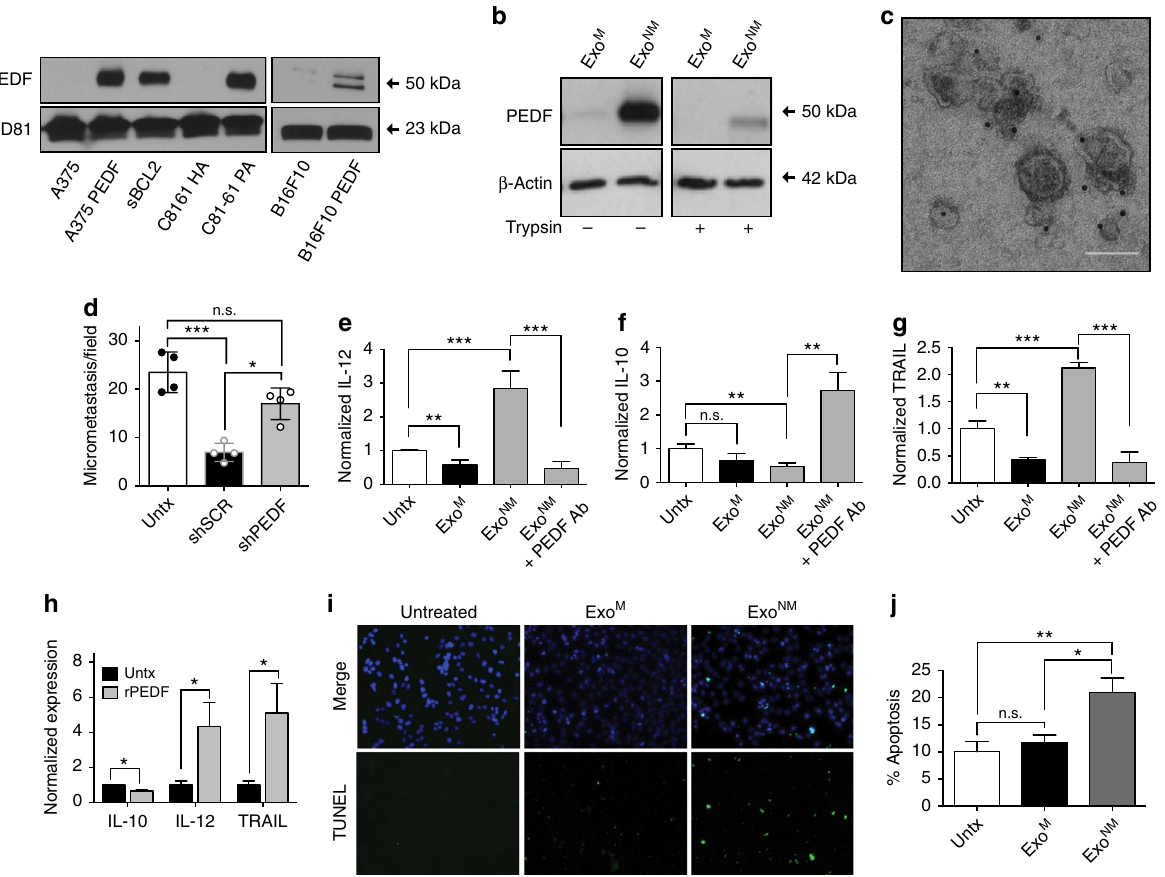
Fig. 5 The involvement of PEDF in exosome-driven melanoma cell clearance. a Western blot shows PEDF enrichment in exosomes from non-metastatic melanoma cell lines (A375 PEDF, SBcl2, C81-61PA, B16F10 PEDF) and the lack of PEDF in the metastatic exosomes (A375GFP, C8161 HA, B16F10 GFP, and C81-61 PA shPEDF). b Limited trypsin digestion indicates that PEDF is tethered to the outer lea fl et of exosomal membranes. Exosomal protein is loaded at 10 μ g per well. c Immunogold staining — TEM of Exo NM con fi rms PEDF localization to exosome surface. Scale bar, 100 nm. d Mice were pretreated with exosomes from non-metastatic C81-61 PA melanoma cells transfected with shPEDF lentiviral vector (shPEDF) or scrambled control shRNA miR (ShScr) ( n = 4, fi ve random images analyzed per animal for each condition). * P < 0.05 and *** P < 0.001 calculated by two-sided Student ’ s t -test in